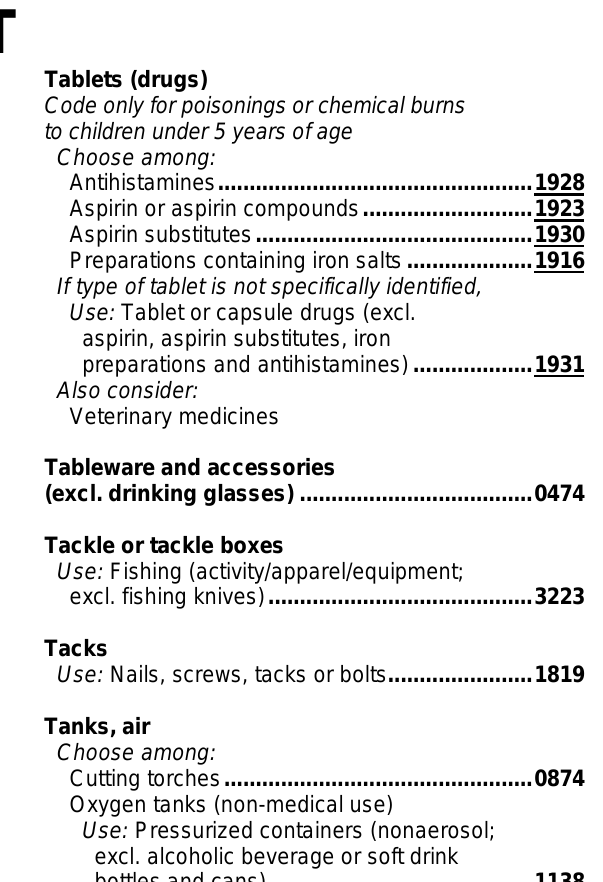
Use: Table tennis (activity/apparel/